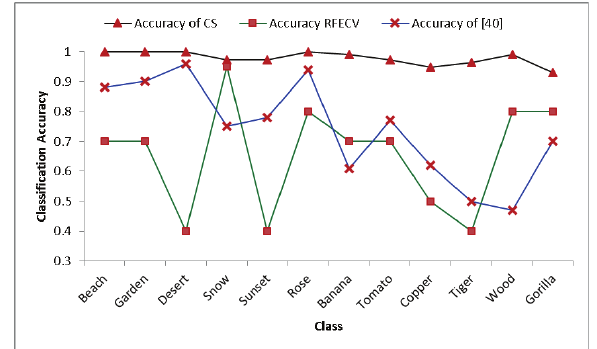
Fig. 3. Comparison of the classification accuracy of the discovered contrast sets with the classification accuracy of the RFECV and Al Aghbari 40 methods.